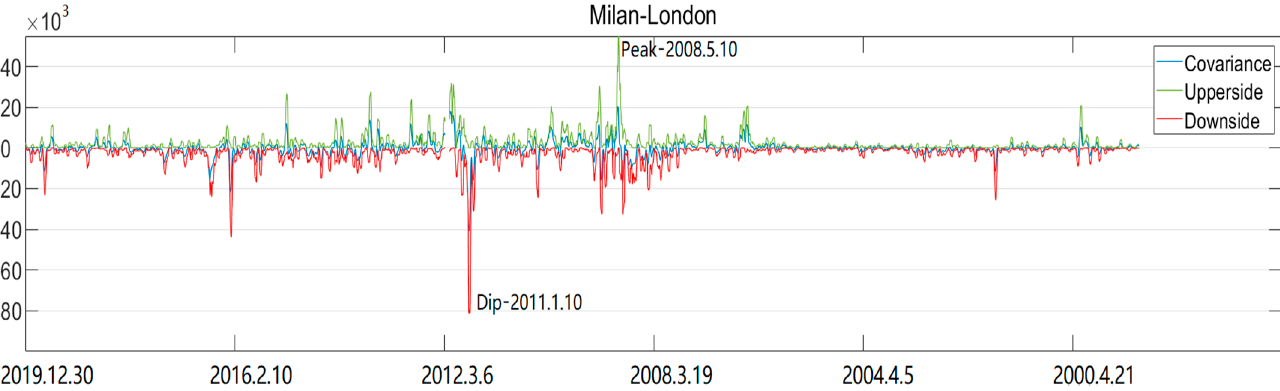
Figure 2. Bi ‐ weekly/semi ‐ covariances between gold price and Milan–London Index UK from the year 2019 back to 1999.